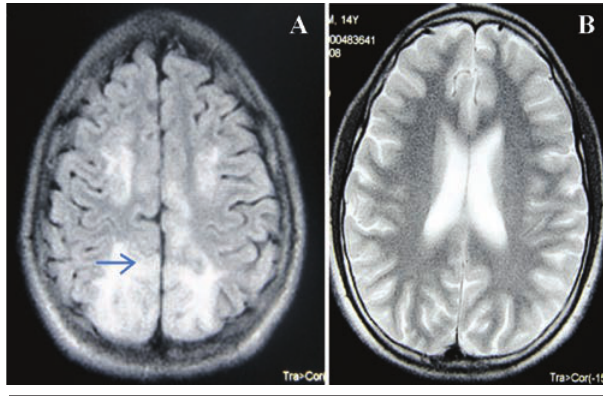
Figure 1. On both legs there were multiple excoriated papular lesions. Figure 2. Magnetic resonance imaging of the brain: abnormal hyperintense signals seen in axial FLAIR in cortical and subcor- tical areas of occipital lobe and anterior parietal/posterior frontal lobes consistent with posterior reversible encephalopathy syn- drome (A). Normal axial T2 image is shown 3 weeks later